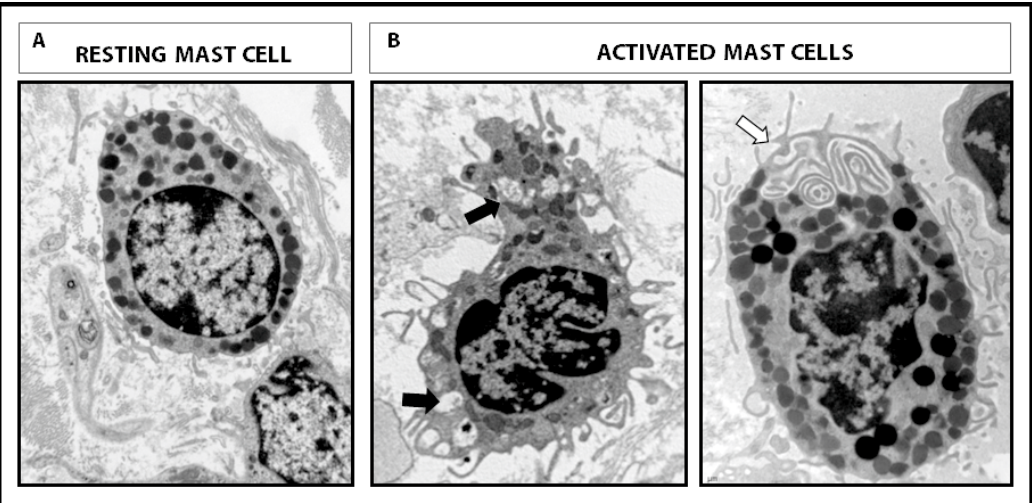
Figure 1. Intestinal mucosal mast cells. Representative micrographs of human mast cells showing different morphology at the ultrastructural level. ( A ) Resting mast cell with intact cytoplasmic granules and lipid bodies, displaying regular plasma cell membrane. ( B ) Activated mast cells showing piecemeal degranulation with loss of intra-granular electrodensity (black arrow) and inter-granular or granule-to-cell membrane fusion and typical channels (white arrow) during anaphylactic degranulation. Magnification 12,000×.